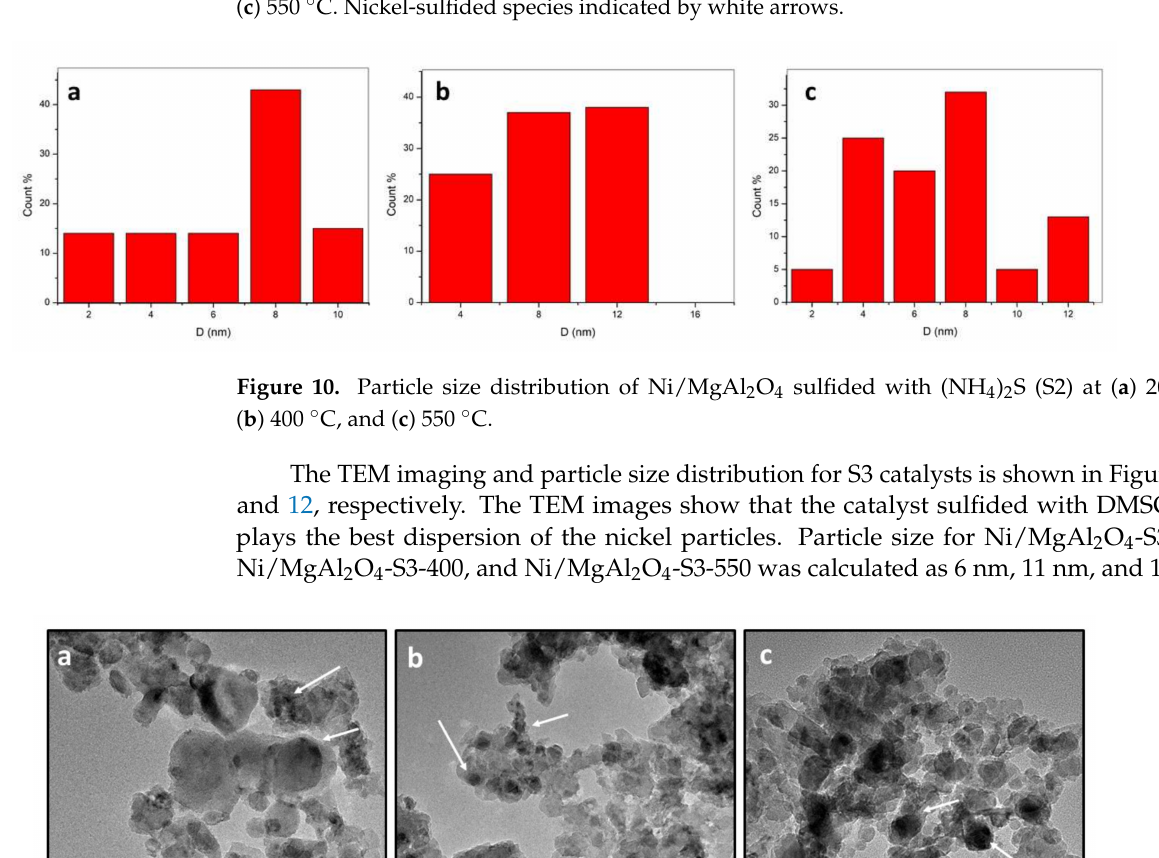
Figure 9. TEM images of Ni/MgAl 2 O 4 sulfided with (NH 4 ) 2 S (S2) at ( a ) 200 ◦ C, ( b ) 400 ◦ C, and ( c ) 550 ◦ C. Nickel-sulfided species indicated by white arrows.